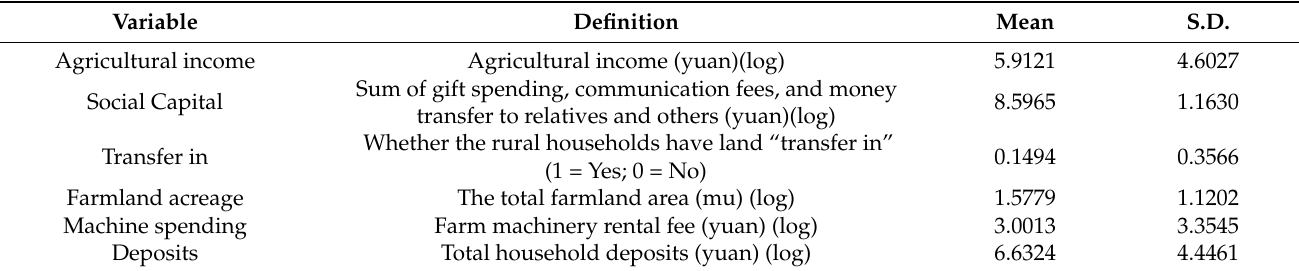
Table 1. The definition and data description of the